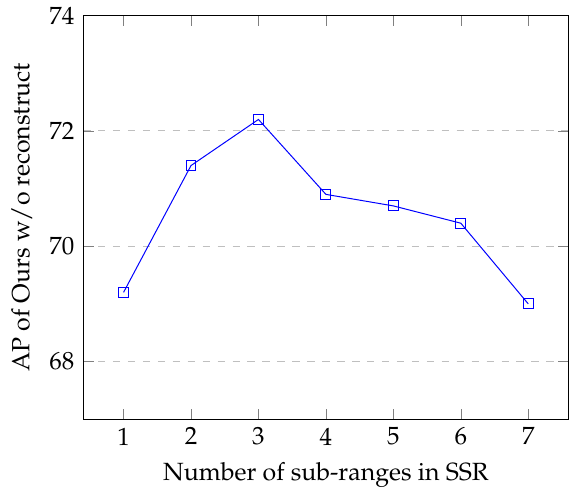
Figure 8. The AP of Ours w/o construct with different number of sub-ranges in